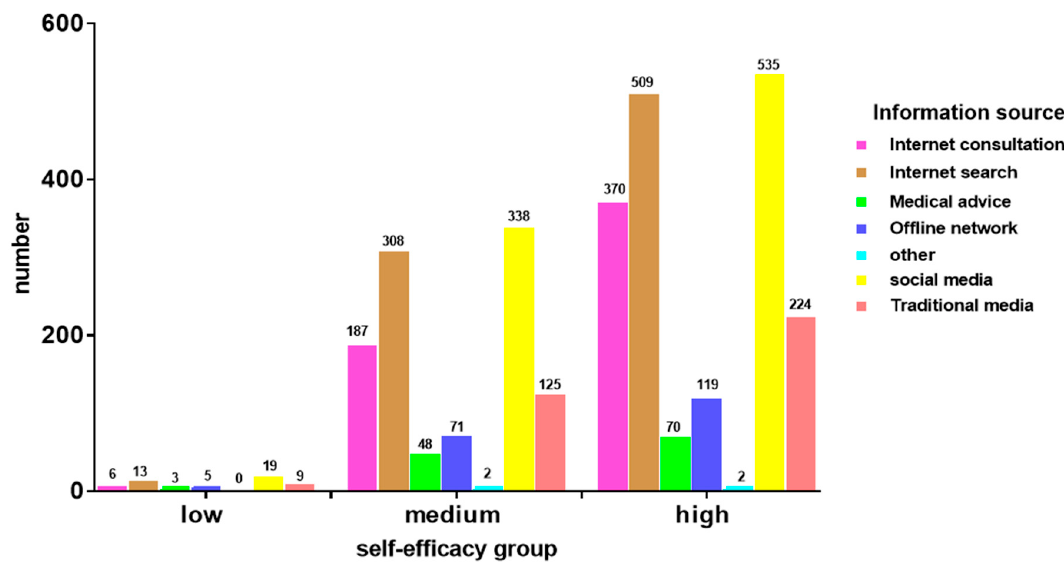
Figure 5. Multiple bar graph of diabetes information source in participants.